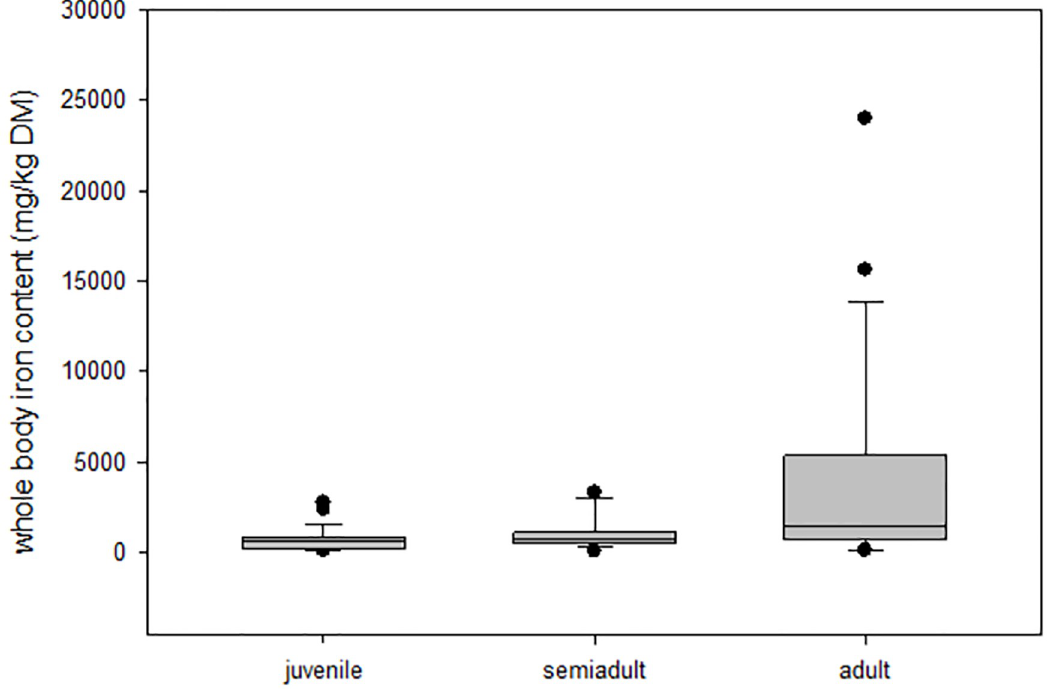
Fig 1. Iron content (mg/kg DM) of the whole body of juvenile, semi-adult and adult snakes (line in the box indicates the median, boxes represent lower quartile to upper quartile (25–75%), lower whiskers 25% − 1.5 ∙ interquartile range, upper whisker: 75% + 1.5 ∙ interquartile Range, dots indicate